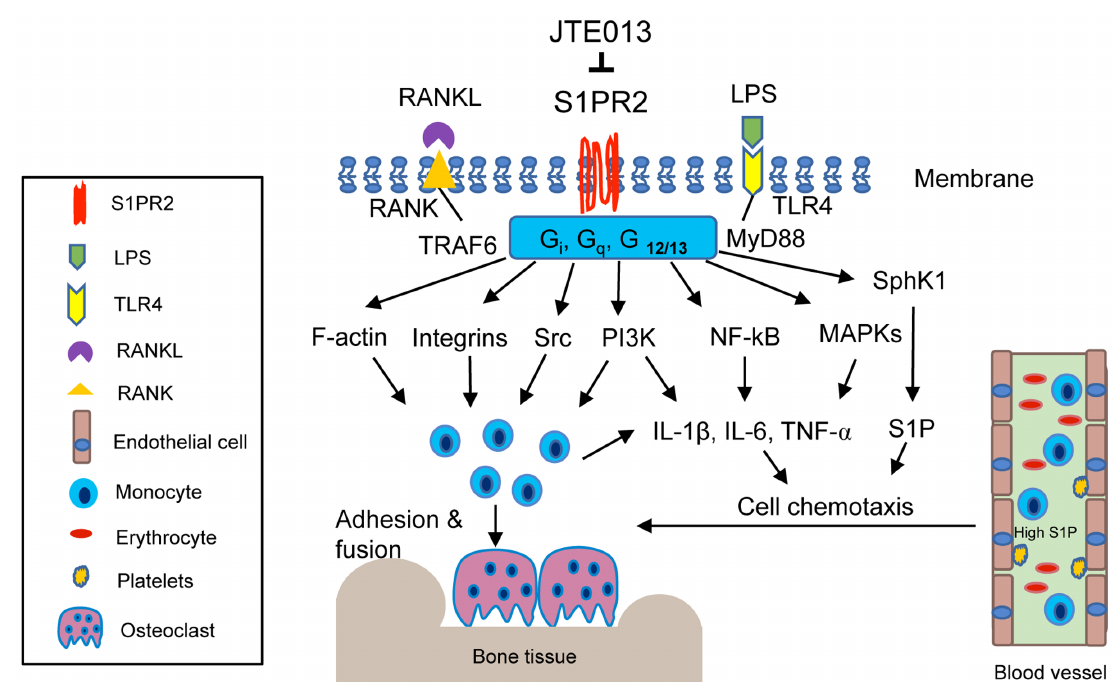
Figure 2. Simplified illustration of biological effects of S1PR2 in inflammatory bone loss diseases. S1PR2 couples with G i , G q , and G 12/13 proteins, which manipulate multiple signaling pathways affecting inflammatory diseases. First, S1PR2 controls PI3K, NF- κ B, and MAPKs signaling pathways induced by LPS, influencing IL-1 β , IL-6, TNF- α inflammatory cytokine release. Second, S1PR2 modulates Sphk1 and S1P generation induced by inflammation. Third, S1PR2 manipulates chemotaxis of osteoclast precursors from blood circulation to bone and soft tissues by modulating inflammatory cytokine and S1P generation. Fourth, S1PR2 controls podosome components (F-actin, integrins, Src, PI3K) induced by RANKL and modulates the adhesion and fusion of osteoclast precursors. S1PR2 possibly interacts with G i , G q , and G 12/13 proteins, RANKL adaptor protein TRAF6, and TLR4 adaptor protein MyD88 in lipid rafts after stimulation by RANKL or